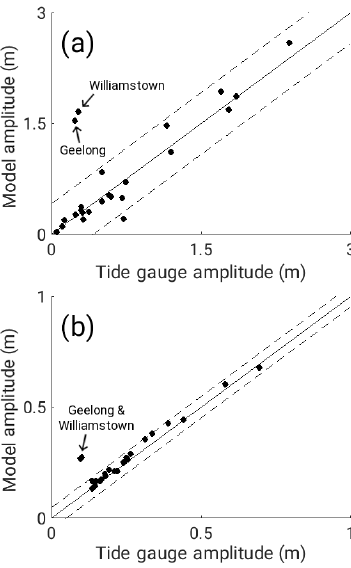
Figure 2. The constituent amplitude at each tide gauge position calculated from GESLA and UHSLC data and the model control simulation for (a) M 2 and (b) K 1 . The solid line marks the zero difference line. The dashed lines mark 1 standard deviation of the difference.